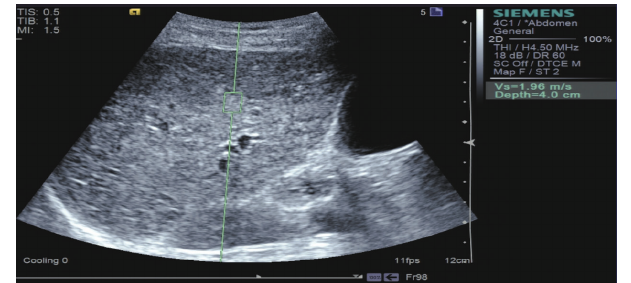
Figure 2 pSWE images in a 63-year-old man with a history of hepatitis B. pSWE of the liver performs with the Siemens system through intercostal access. The measurement is given in meters per seconds. The hardness of the liver is 1.96m/s, which is above the normal